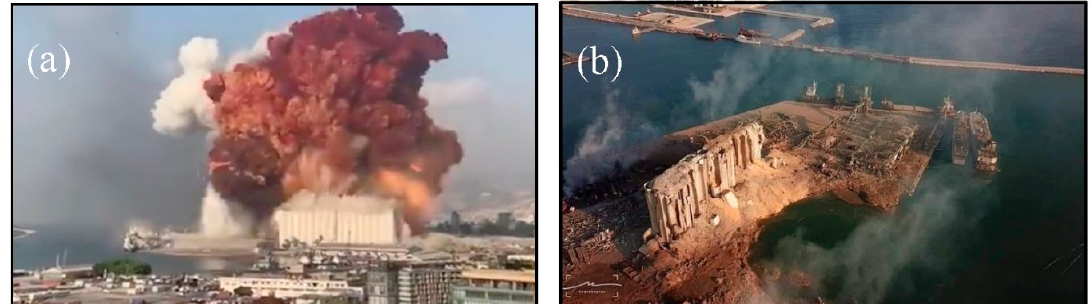
Figure 1. Beirut blast ( a ) photo shows the red and orange plumes generated by the explosion on 4 August 2020 ( b ) aerial view showing the damage on 5 August 2020.